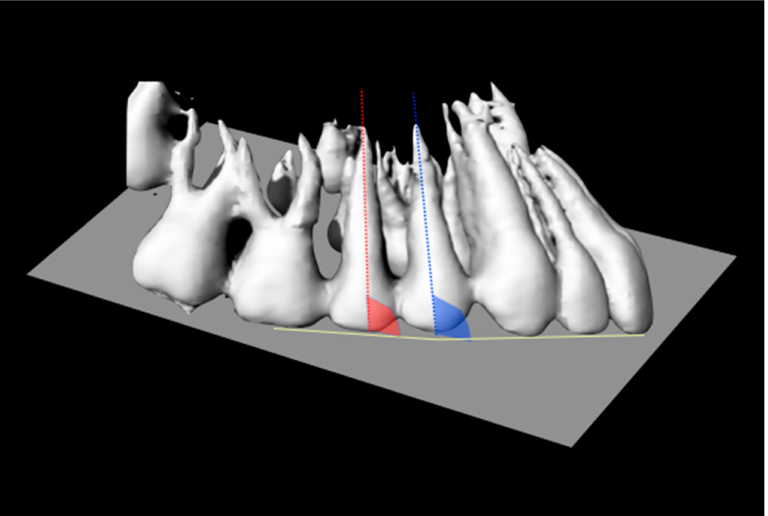
Figure 4. Measurement of mesiodistal inclination on CBCT. Mesiodistal angulation was defined as the angle between the Proper vertical axis and the projection of Proper vertical axis on FACC plane.